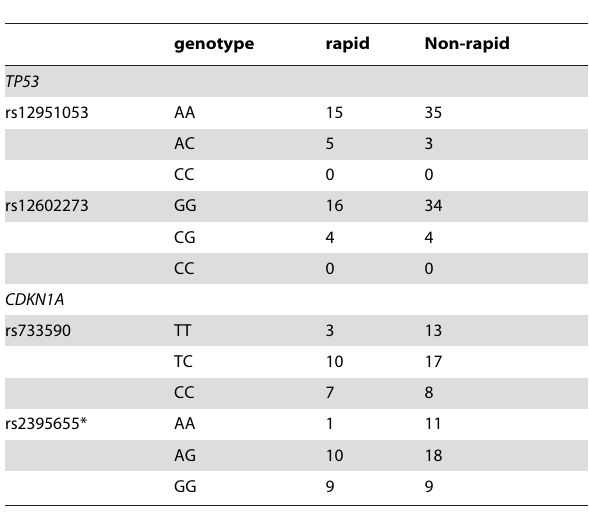
Table 2. Genotype and lung function decline.